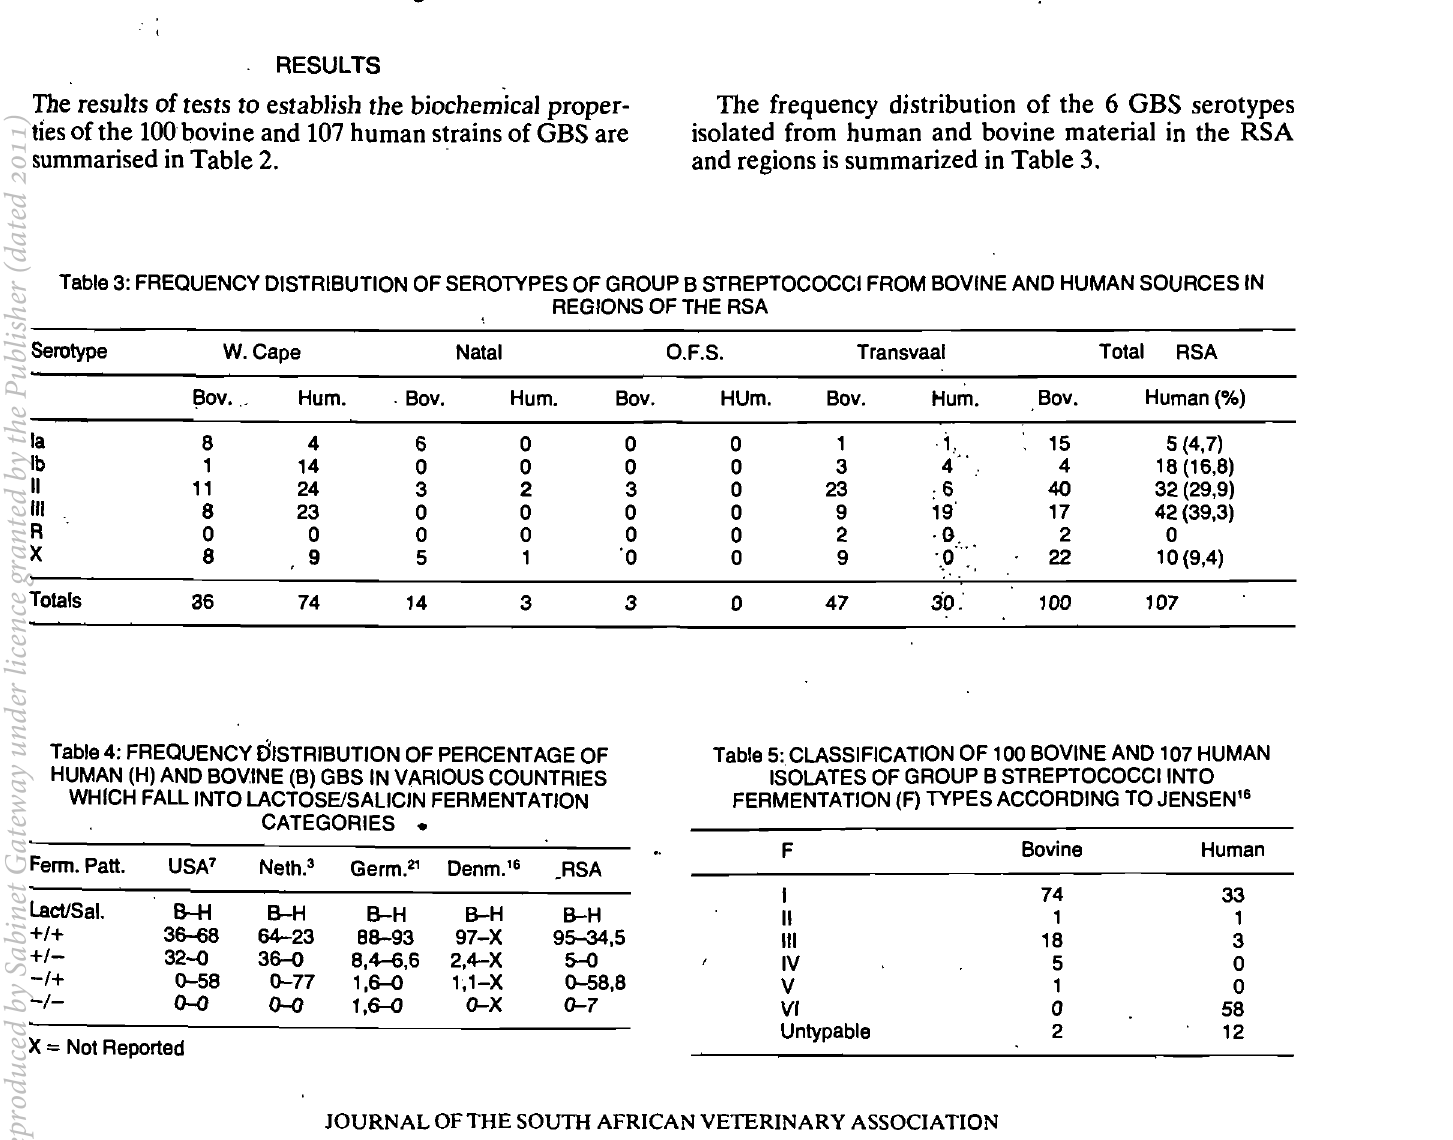
Table 4: FREQUENCY d,STRIBUTION OF PERCENTAGE OF Table 5: CLASSIFICATION OF 100 BOVINE AND 107 HUMAN HUMAN (H) AND BOV./NE (B) GBS IN VARIOUS